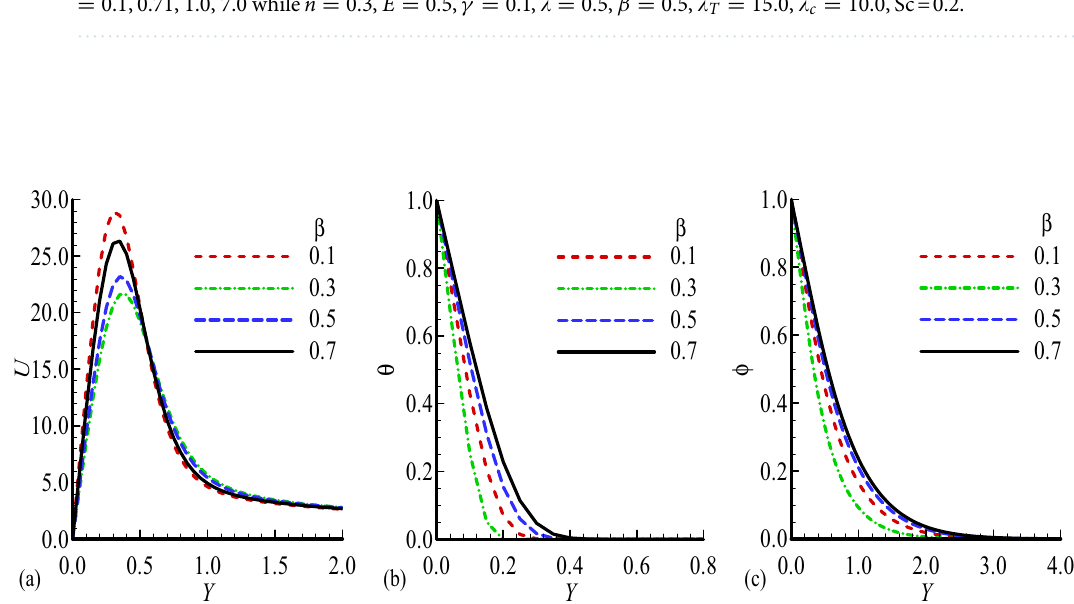
Figure 5. Dimensionless ( a ) Velocity U , ( b ) temperature θ and ( c ) mass distribution φ for different values of Pr = 0.1, 0.71, 1.0, 7.0 while n = 0.3 , E = 0.5 , γ = 0.1 , (cid:31) = 0.5 , β = 0.5 , (cid:31) T = 15.0 , (cid:31) c = 10.0, Sc = 0.2.